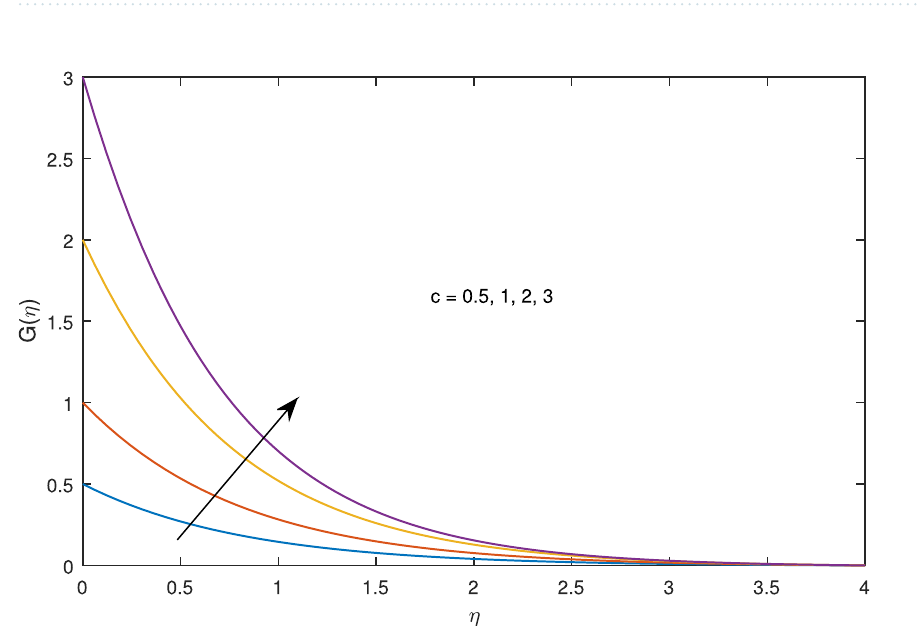
Figure 3. Effects of variation of c on radial velocity, when w 6.2 . Pr =